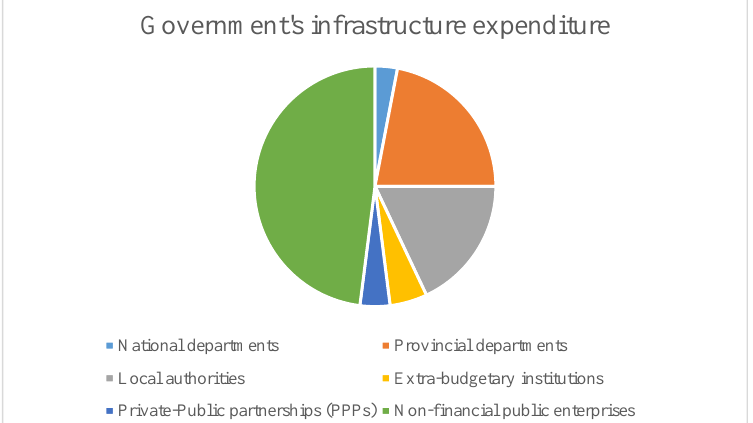
FIGURE 1: Government’s infrastructure spending (2011/12 fiscal year)